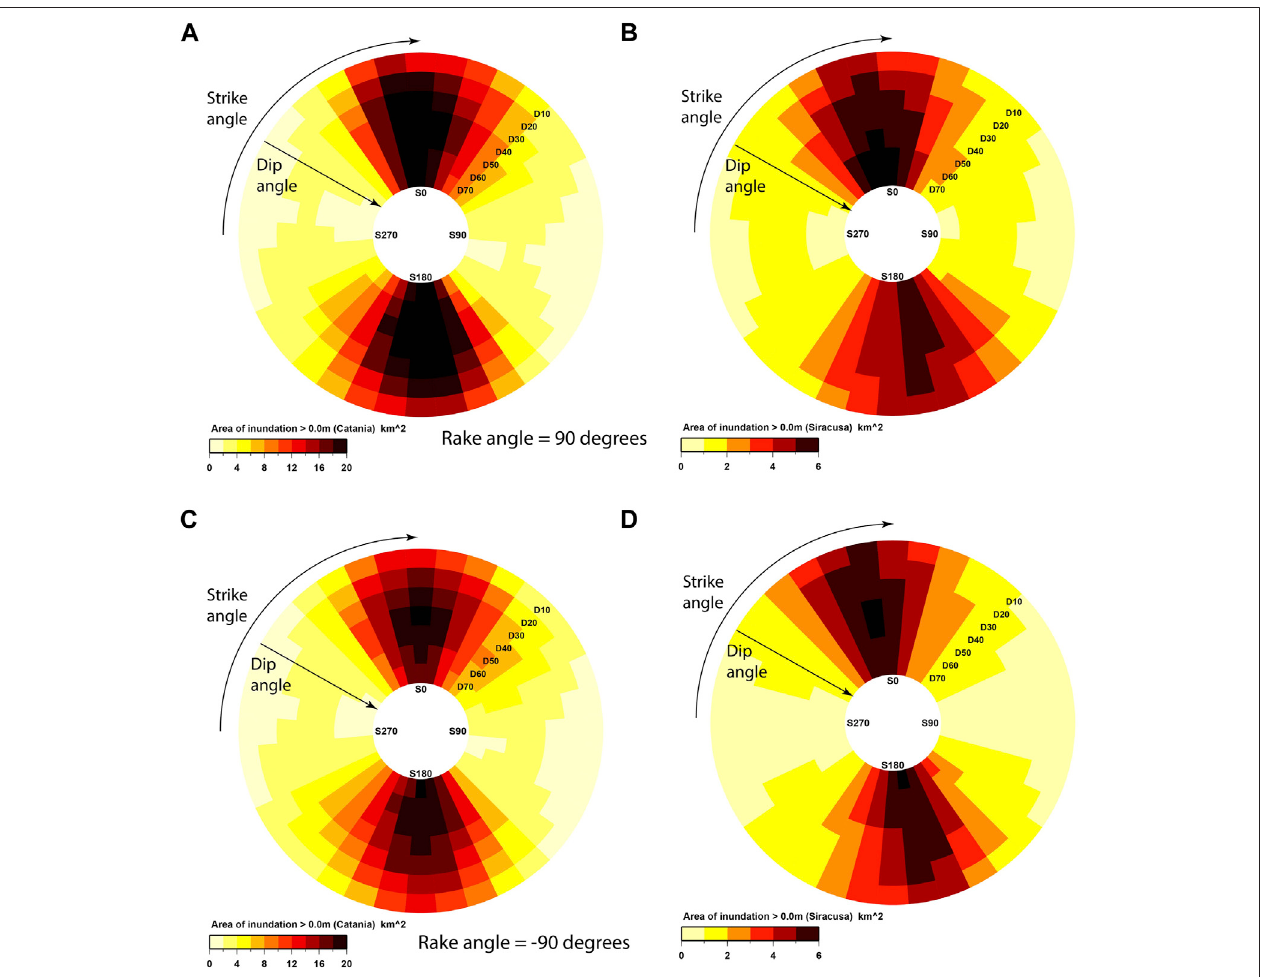
FIGURE 8 | Area of tsunami inundation in km 2 for Catania (A,C) and Siracusa (B,D) for earthquake scenarios with fault centers at point D (signi fi cantly offshore). Panels (A,B) display inundationforrake (cid:1) 90 o (reversefaulting) and panels (C,D) for rake (cid:1) − 90 o (normal faulting). Thecolour scalesdifferfor thetwolocations, re fl ecting the areas subject to inundation, but are identical for the normal and reverse sources at both